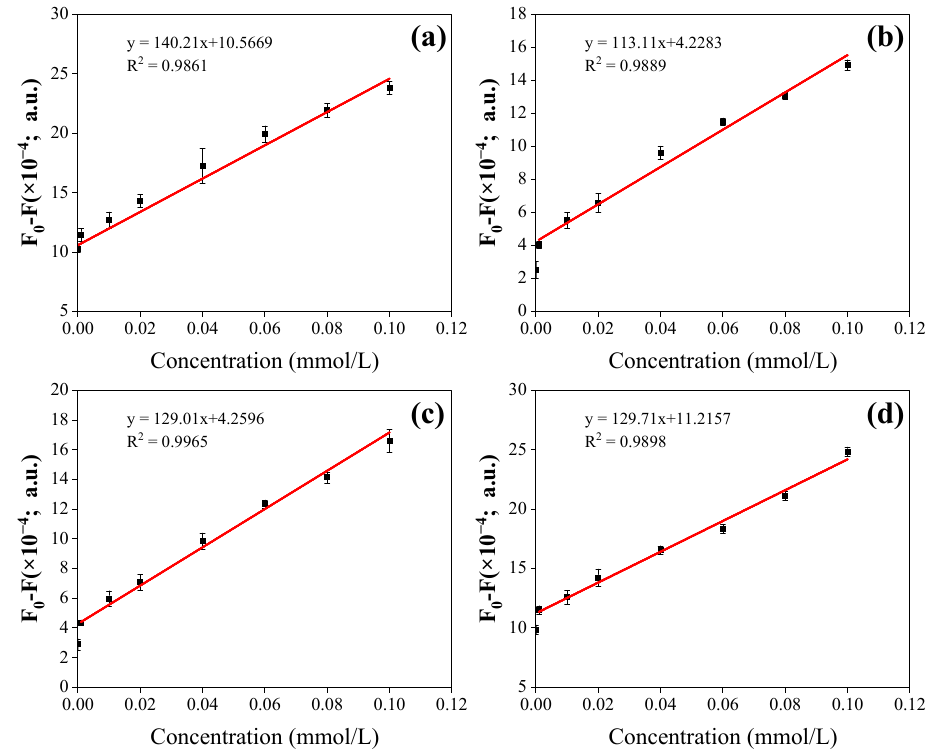
Figure 9. The linear relationship between the fluorescence intensity of CMC/Eu (III) at 615 nm and acrylamide concentration in ( a ) waterborne food simulants, ( b ) acidic food simulants, ( c ) alcoholic beverage simulants, and ( d ) greasy food simulants (0.1 μ M–100 μ M).